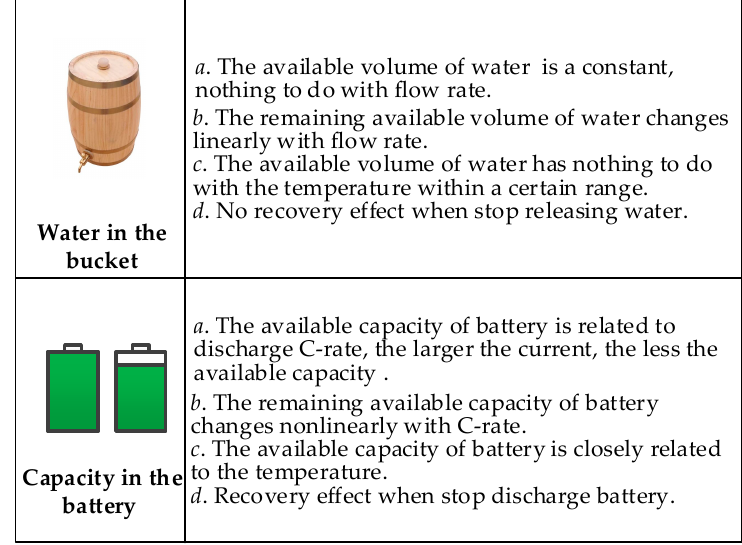
Figure 1. Battery capacity is not similar to water in a bucket.